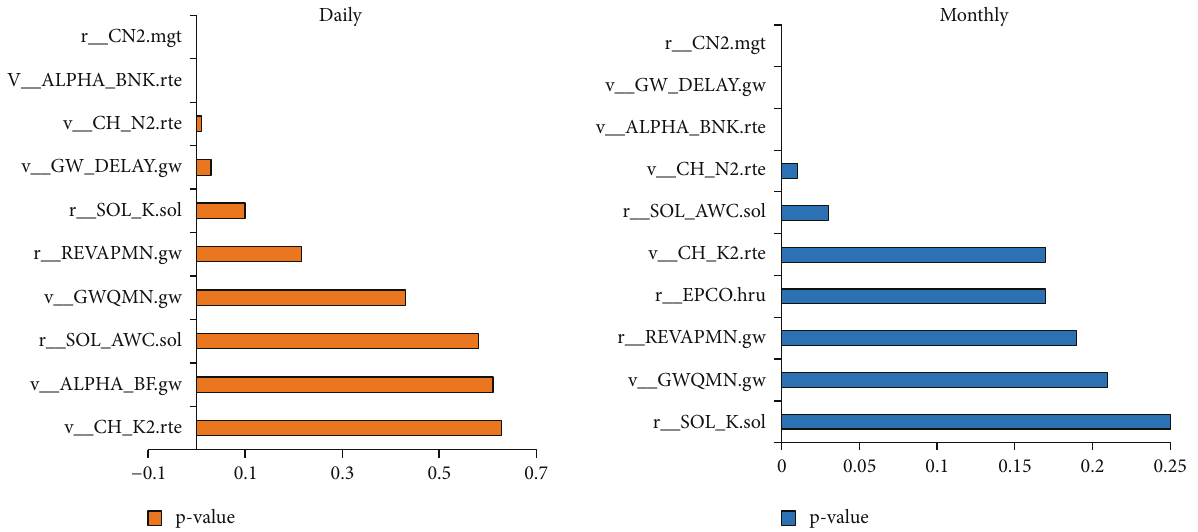
Figure 6: t -Stat of the daily and monthly most sensitive parameters using the SUFI-2